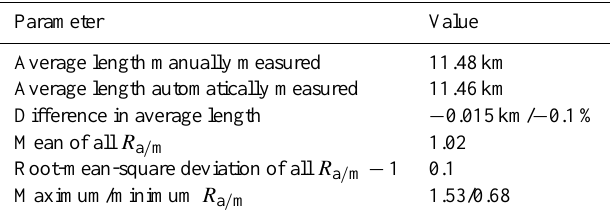
Table 1. Evaluation of algorithm performance in East Greenland based on 100 randomly selected glaciers. R a / m denotes the ratio of automatic length divided by manual length.